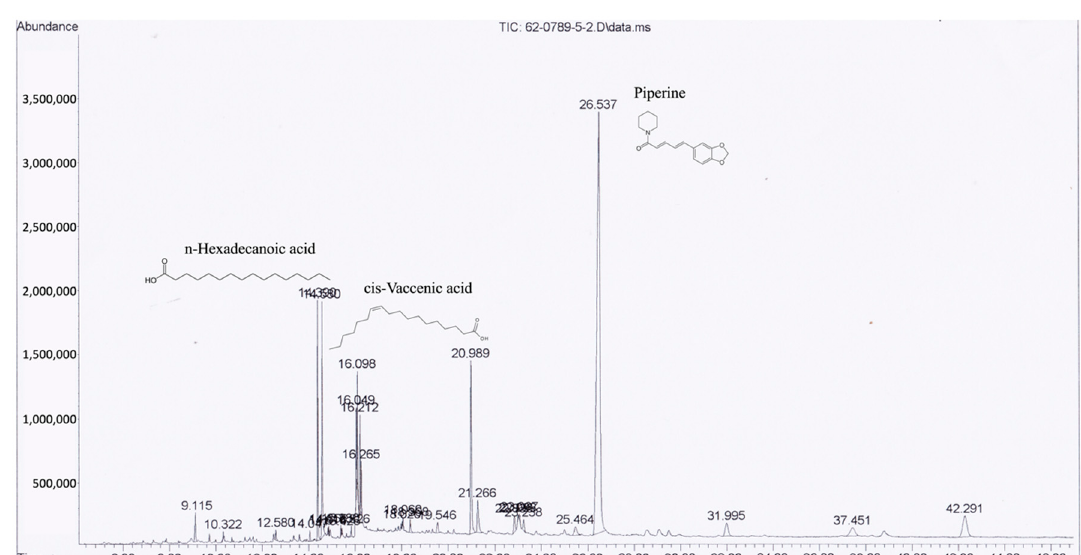
Figure 2. GC-MS chromatograms of both ethanolic ( A ) H. cordata and ( B ) P. ribesioides extracts. Phytochemicals in both plant extracts were analyzed using DB-5MS column with Agilent technology GC 7890A coupled to Agilent technology MSD 5975C (EI). Table 2. Phenolic acid compositions and flavonoids of both ethanolic H. cordata and P. ribesioides. Retention Times (Rt) H. cordata P. ribesioides Compounds